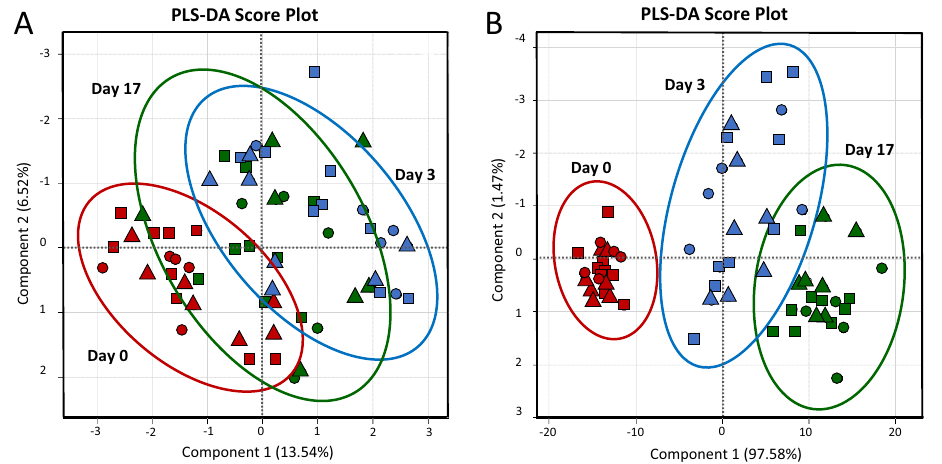
Figure 1. PLS-DA score plots for overall comparison of fatty acid (panel A) and non-volatile polar metabolite (panel B) profiles of colostrum (day 0; red), transient milk (day 3; blue) and mature milk (day 17; green) samples collected from sows in different parity numbers. The blocks in ( (cid:31) ), ( (cid:31) ) and ( (cid:31) ) shape correspond to the samples collected from sows in parity 1, parity 2–6 and parity 7,